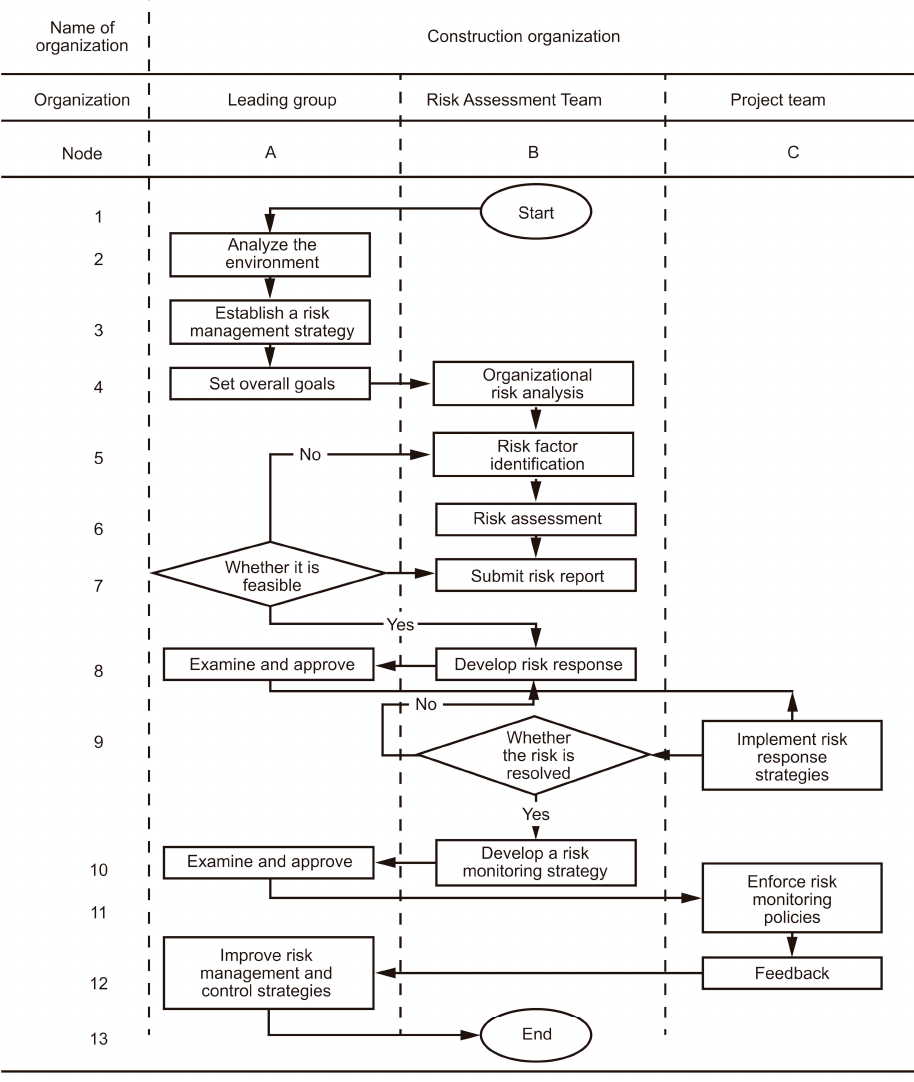
Figure 9. Risk management process for steel bracing projects.